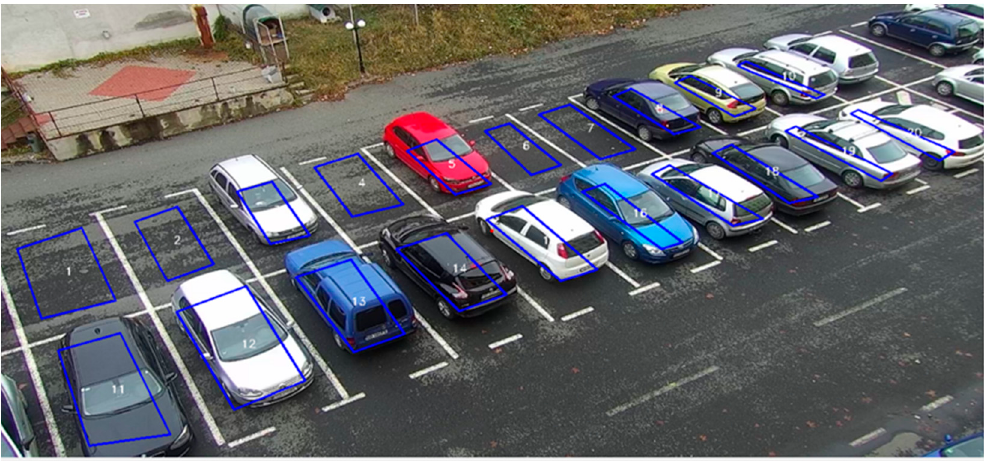
Figure 2. Defined parking area map on benchmark 1.